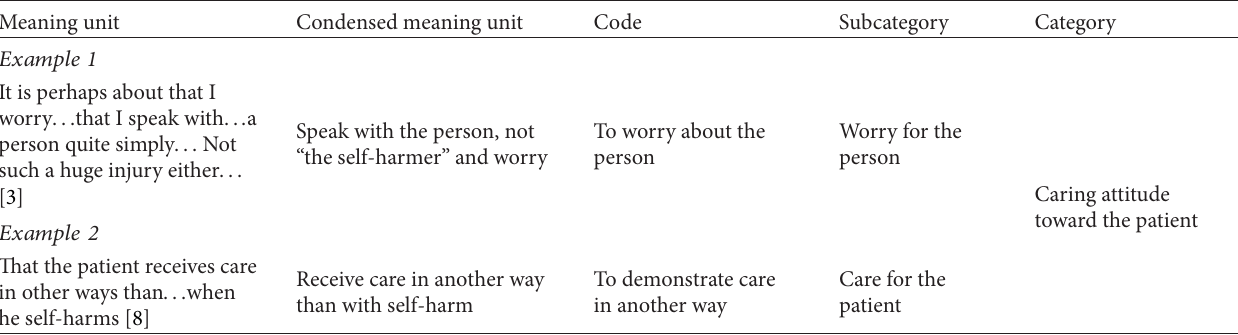
Table 1: Examples of the condensation-abstraction process from meaning units to category and main category: challenging and collaborative nurse-patient